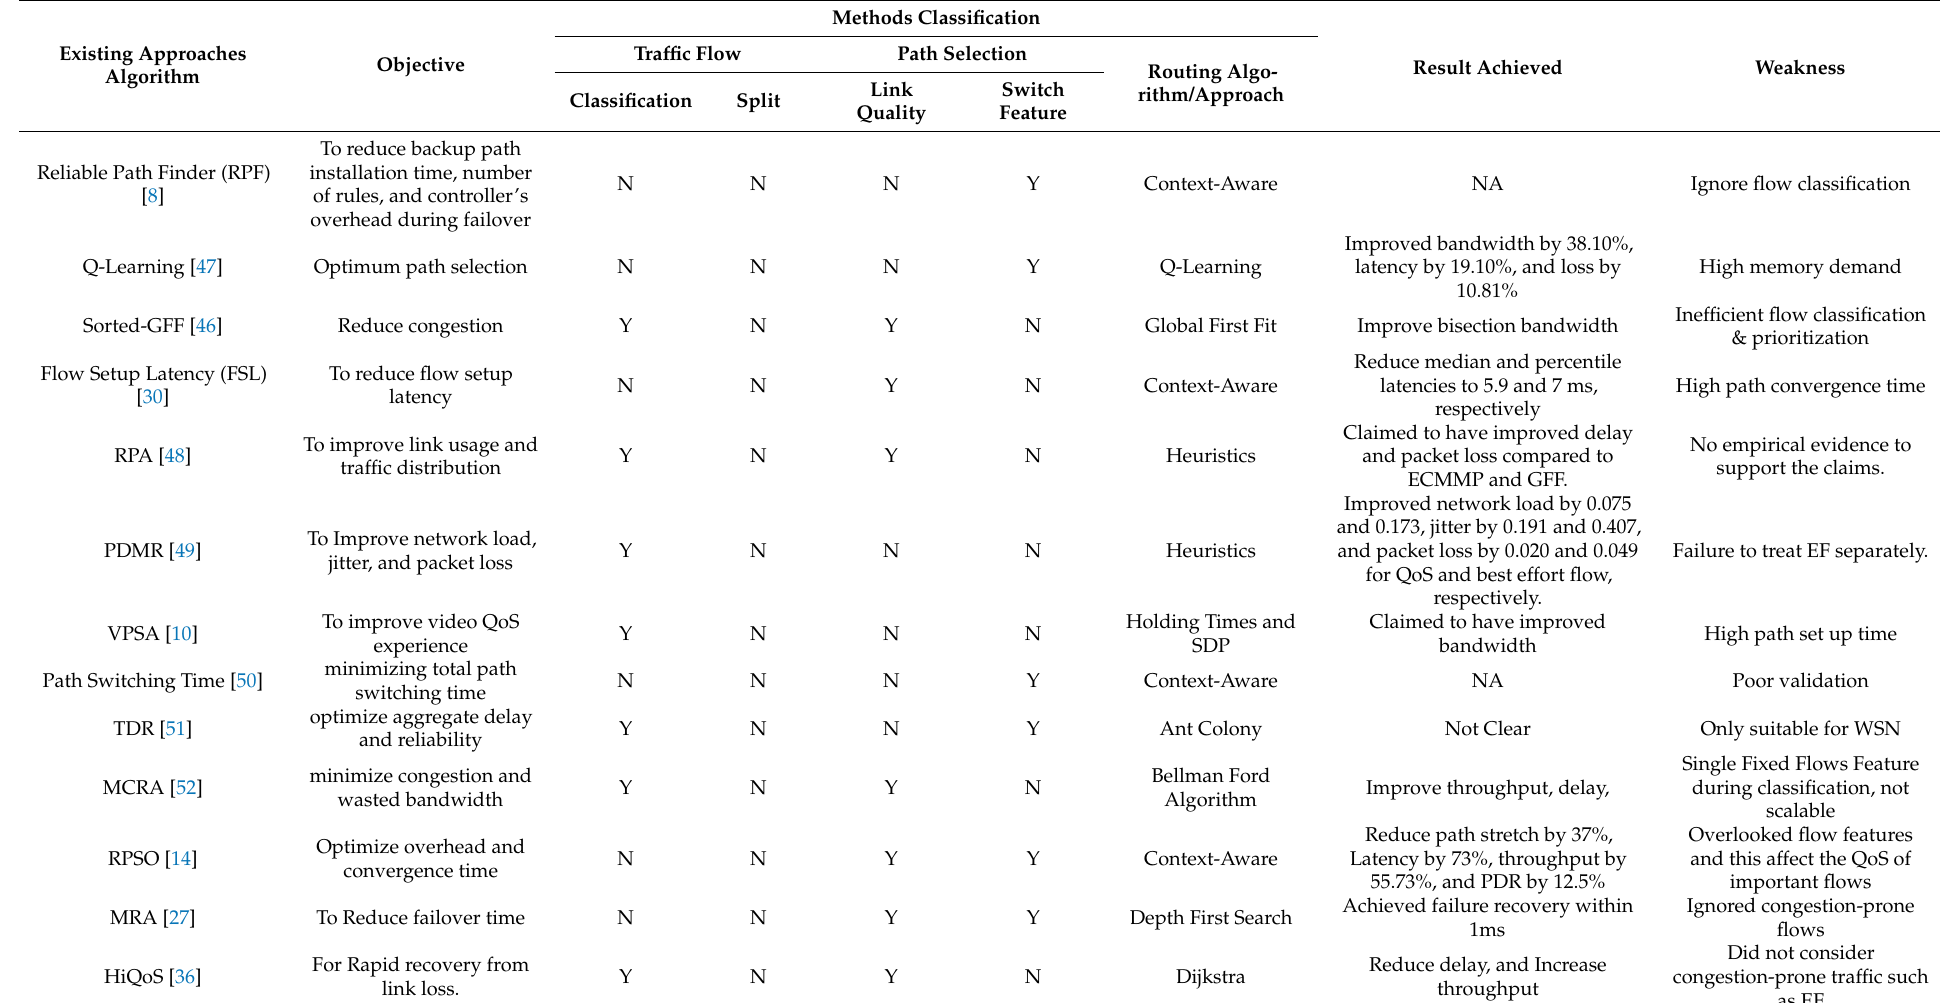
Table 1. Summary of Related